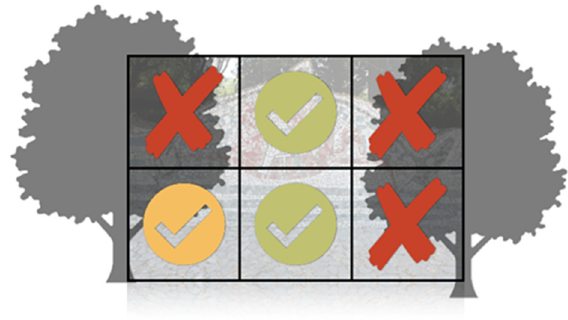
Figure 1. Target blocks recognition and